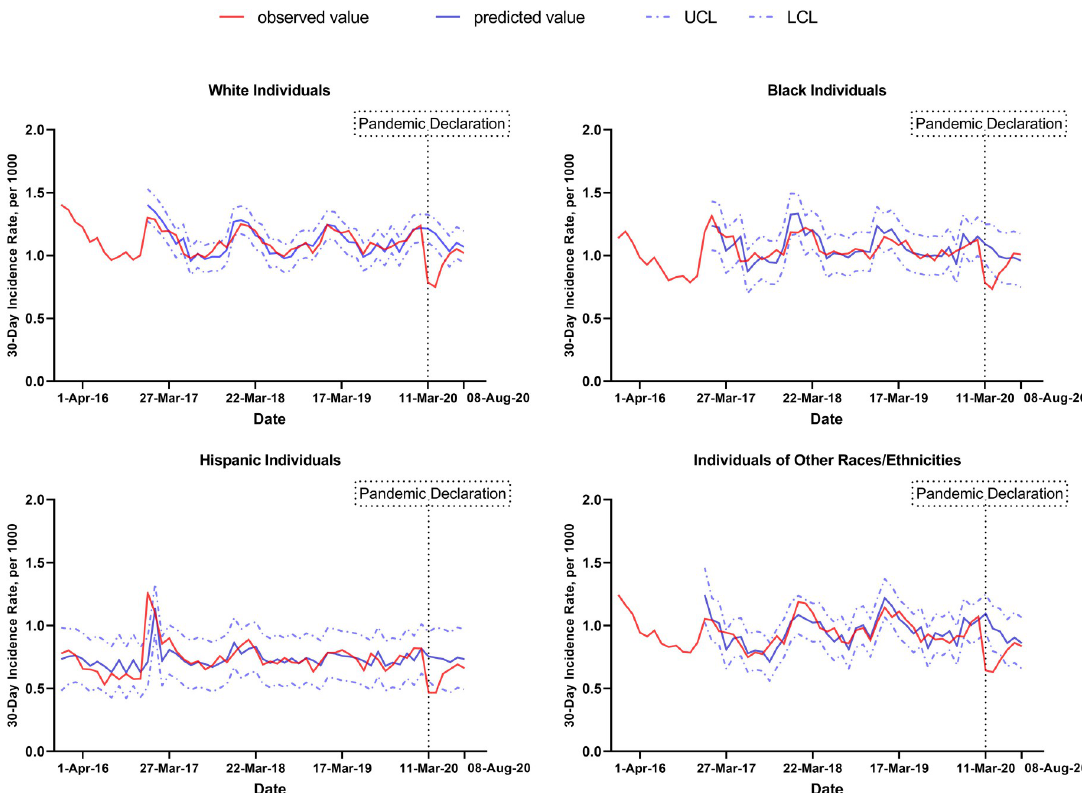
Fig 3. Observed and predicted new atrial fibrillation diagnoses by race and ethnicity. Abbreviations: UCL, upper confidence limit; LCL, lower confidence limit.